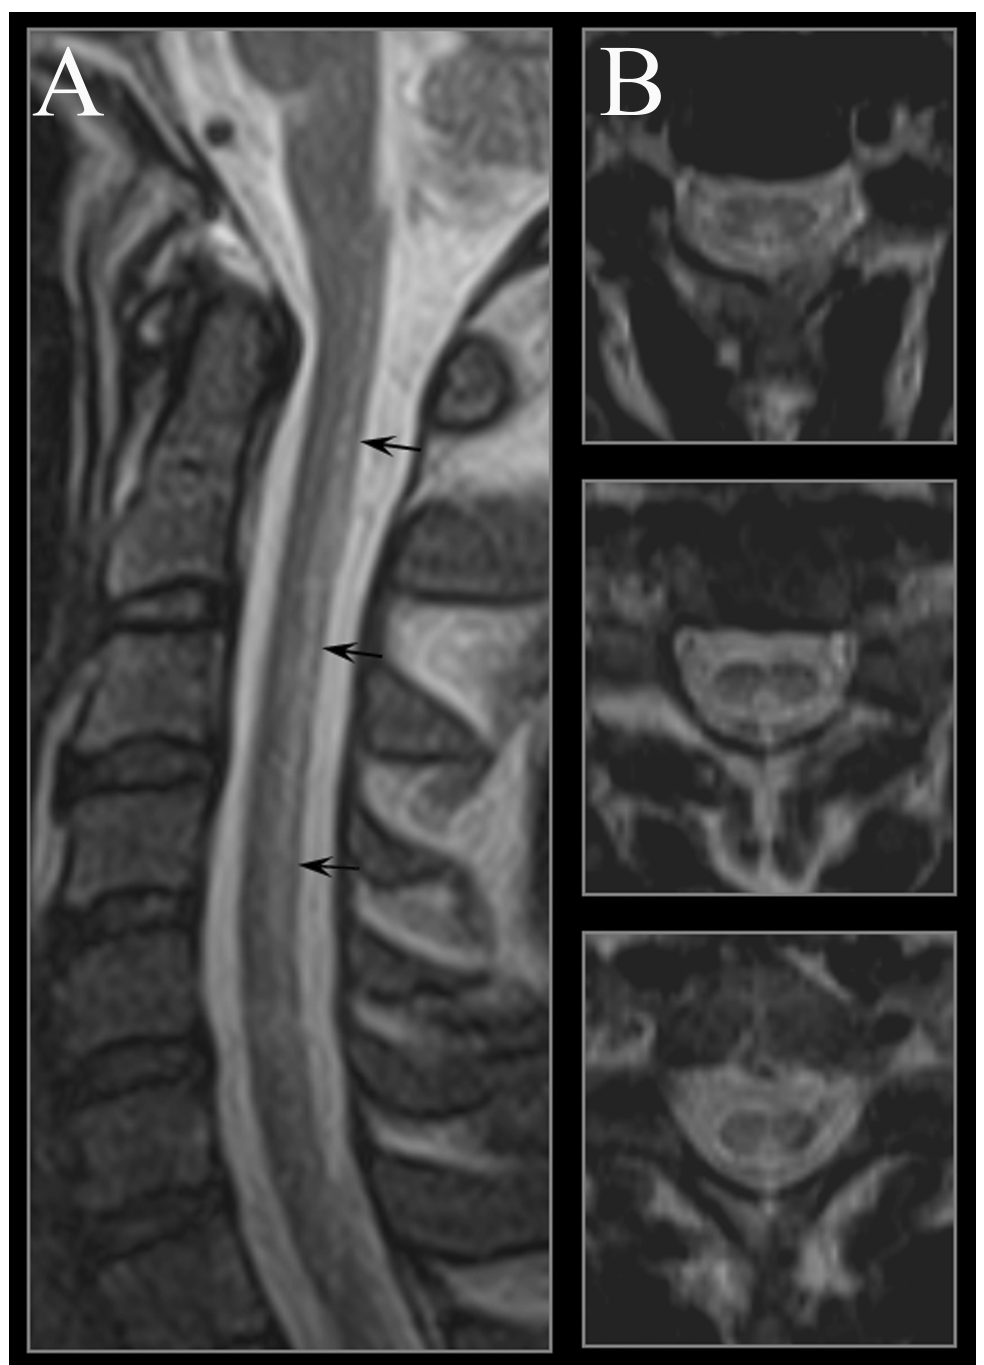
Figure 2. Cervical spinal cord MRI in a 49-year-old male presenting with subacute combined degeneration due to a deficit of B12. ( A ) The midsagittal T2 weighted image shows linear hyperintensity in the posterior portion of the cervical tract of the spinal cord (black arrows). ( B ) Axial T2 weighted images reveal the selective involvement of the posterior